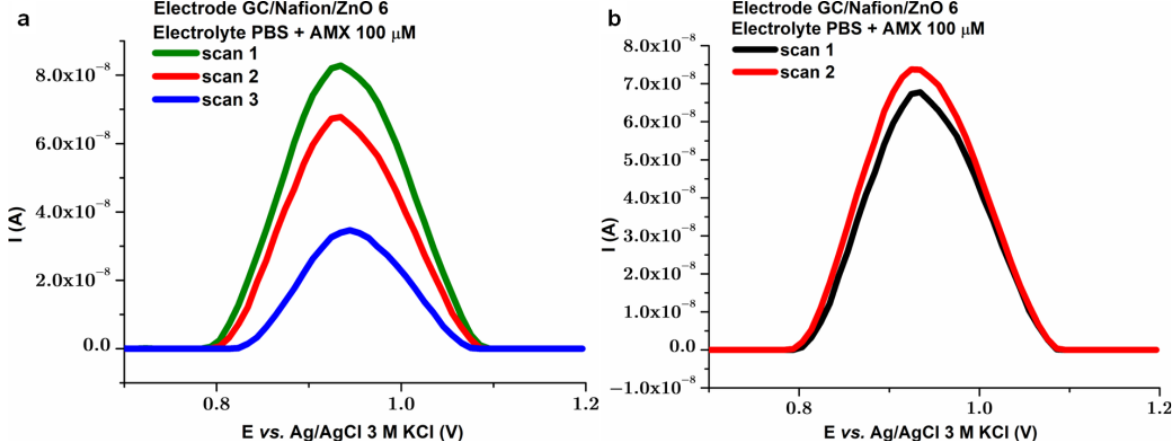
Figure 6. Differential pulse voltammetry curves in PBS with AMX 100 µM consecutive scans using GC/Nafion ZnO 6 electrode with ( a ) 1 h drying time, ( b ) 24 h drying time.